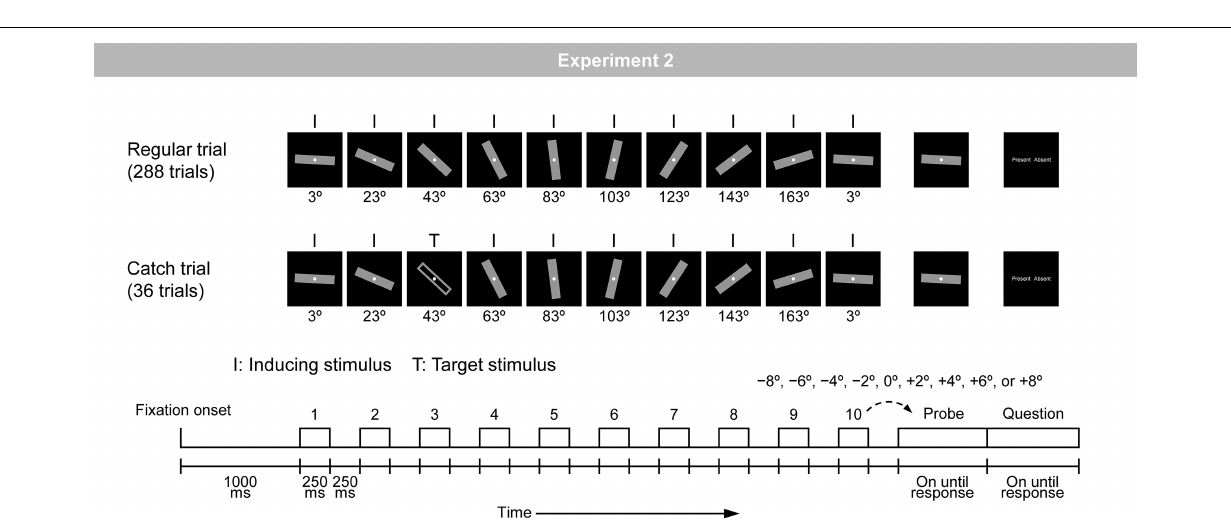
FIGURE 2 | Schematic illustration of the regular and catch trials in Experiment 2. A bar was rotated regularly with a step of 20 ◦